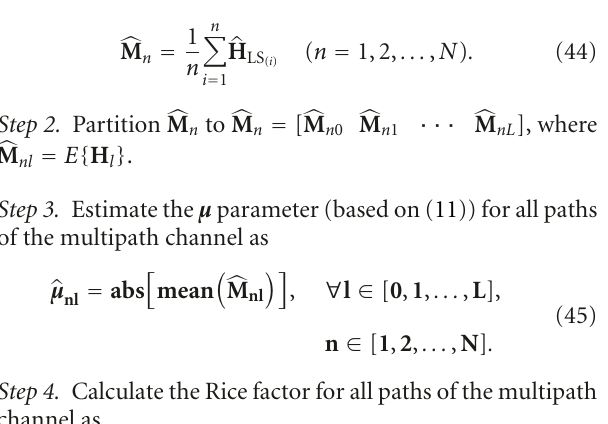
Figure 4: Computational complexity of the LS-based and MMSE channel estimators (Real multiplications for N T = N R = 2 and N N T = R = 4).